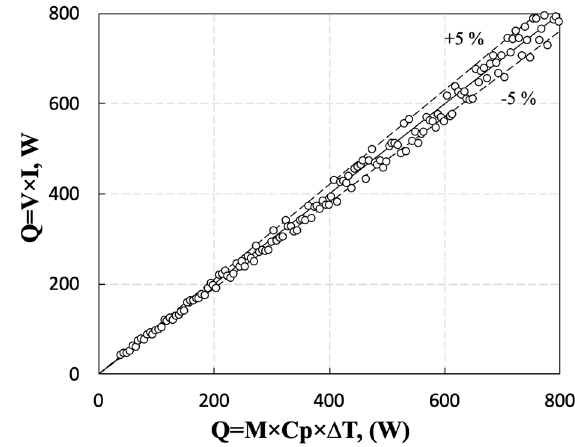
Figure 2. Heat loss analysis conducted on the test section of the test facility.